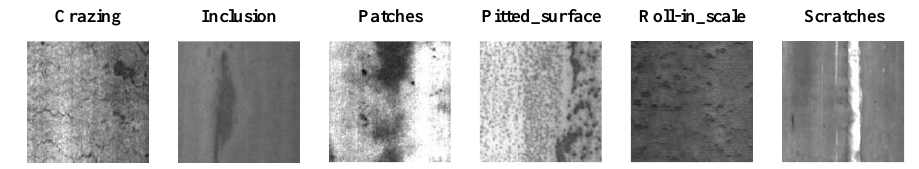
Figure 9. The fault samples of 6 defect types.